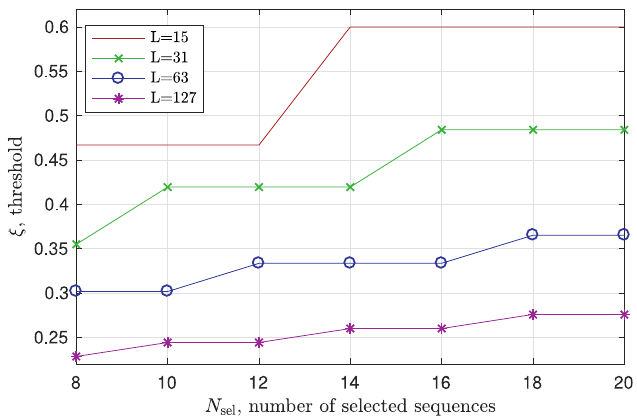
Fig. 3. Threshold levels for 15 to 127 chip-long chaotic spreading sequences.